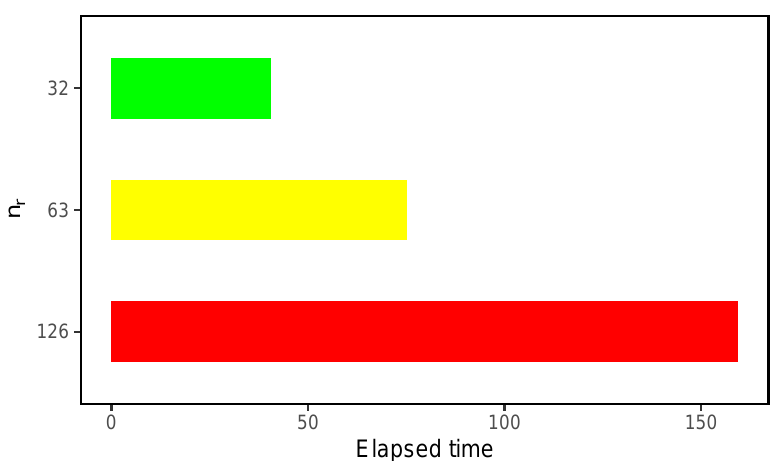
Figure 7. Elapsed time (in seconds) required for the detection algorithm per number of ray strips for synthetic data.